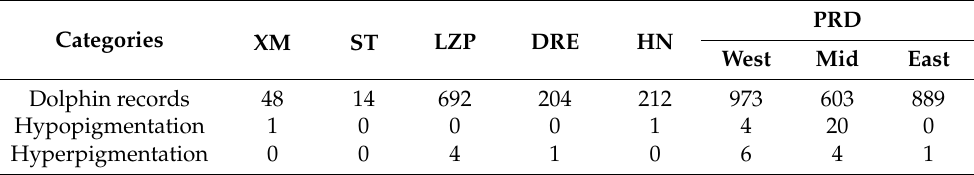
Table 2. Summary of the anomalous body color patterns documented amongst Indo-Pacific humpback dolphins from the Xiamen harbor (XM), the waters off Shantou city (ST), the east coast of Leizhou Peninsula (LZP), the Dafeng River Estuary and its surrounding waters (DRE), the southwestern coast of Hainan Island (HN), and the Pearl River Delta region (PRD).